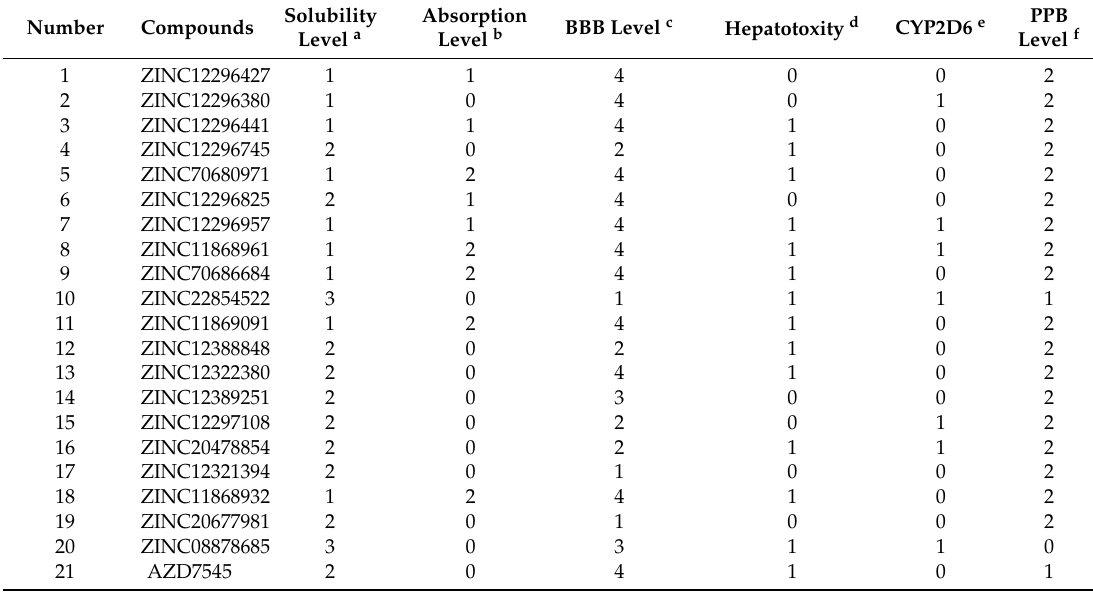
Table 2. ADMET (Adsorption, Distribution, Metabolism and Excretion) properties of